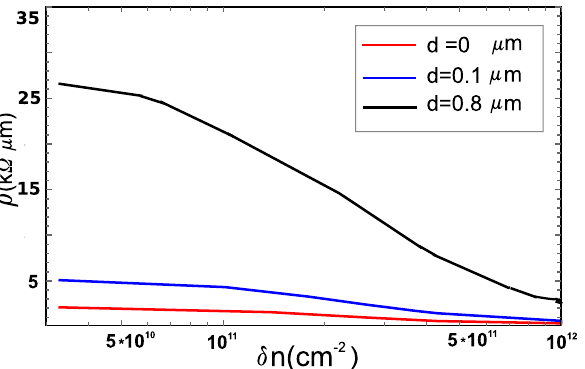
300 K and D = 1 µ m in the presence of = 13.2 ◦ , the strength of the partial dipole ω =45 ◦ . The deformation =